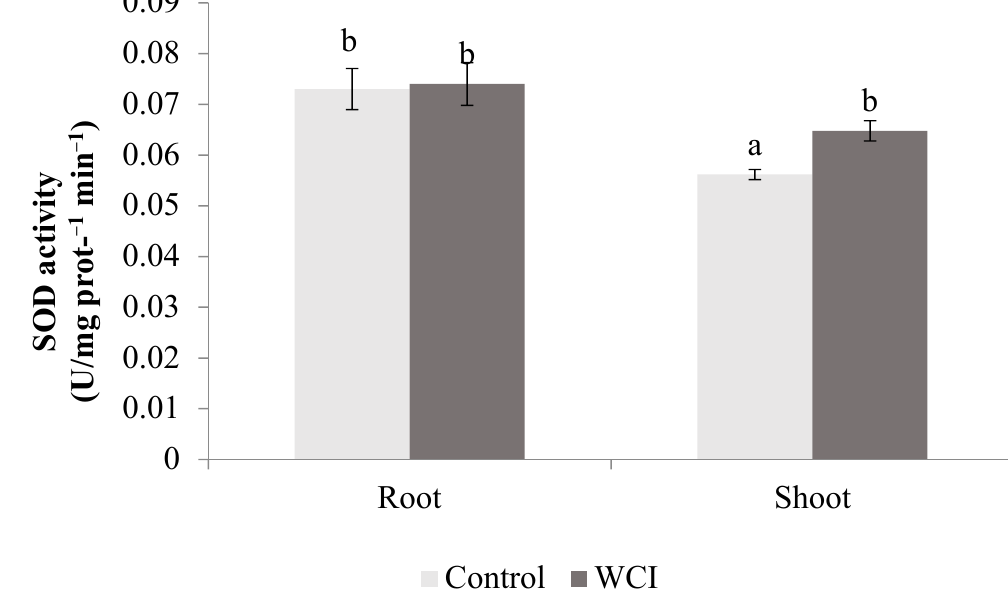
Figure 7. The effect of woolly cupgrass infestation (WCI) on the SOD activity of maize 21 d.a.s. (values are means ± SD, n = 5). Small letters (a, b) show significant differences between treatments based on independent t -test ( p < 0.05).